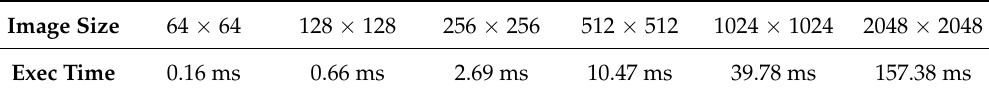
Figure 2. Robustness of vibration features with pixel-level digital filters. Table 1. Execution times on